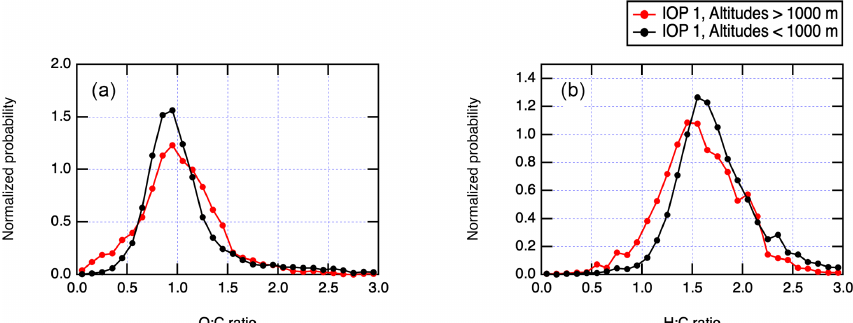
Figure 5. Overview of organic chemistry for IOP 1 using AMS measurement periods where [Org] > 0.15µgm − 3 . All elemental ratios were calculated using the Canagratna et al. (2015) method. (a) AMS O : C ratios for boundary layer and free-troposphere altitudes. (b) AMS H : C ratios for boundary layer and free-troposphere